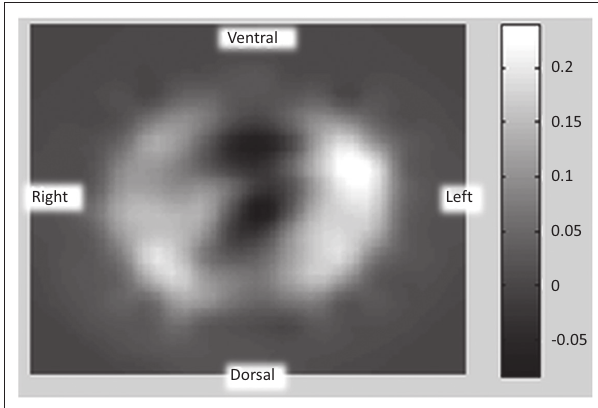
FIGURE 1: Functional electrical impedance tomography image from a participant (aged 4–6 years) in supine position. Lighter areas represent a higher impedance change (greater ventilation) and darker areas indicate areas of a smaller impedance change (poorer